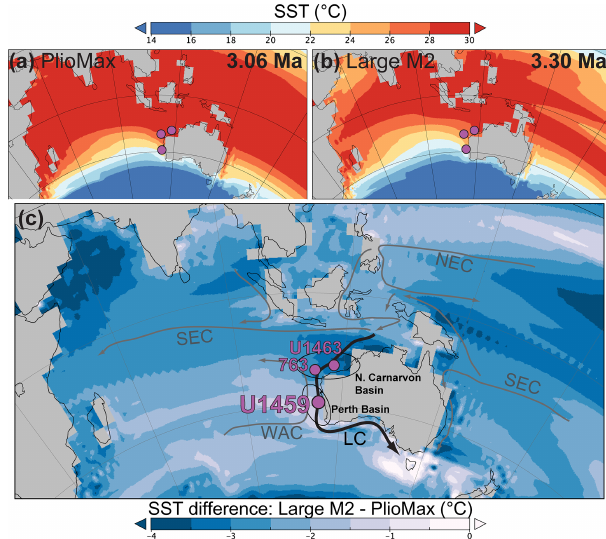
Figure 2. Pliocene modeled SSTs. (a) Warm Pliocene simulation “ PlioMax ” for Marine Isotope Stage (MIS) K1 (3.06Ma orbit and 405ppm CO 2 ; Prescott et al., 2018). (b ) Cold Pliocene simulation “ Large M2 ” for MIS M2 (3.30Ma orbit and 280ppm CO 2 ; Dolan et al., 2015). (c) The SST difference between the cold and warm Pliocene simulations suggests a reduction of the latitudinal SST gra- dient along the Leeuwin Current (LC) pathway during glacials. This modeling result does not match proxy results. Paleoceanographic proxy data from De Vleeschouwer et al. (2019b) suggest a steeper SST gradient along the LC pathway during glacials compared to interglacials. This misrepresentation in the model likely occurs be- cause these particular models do not consider the effects of shelf exposure and a sea-level-induced reduction in shallow-water ITF transport. Both processes are crucial in understanding climate and ocean dynamics on secular and astronomical timescales. NEC is the North Equatorial Current. SEC is the South Equatorial Current. WAC is the West Australian